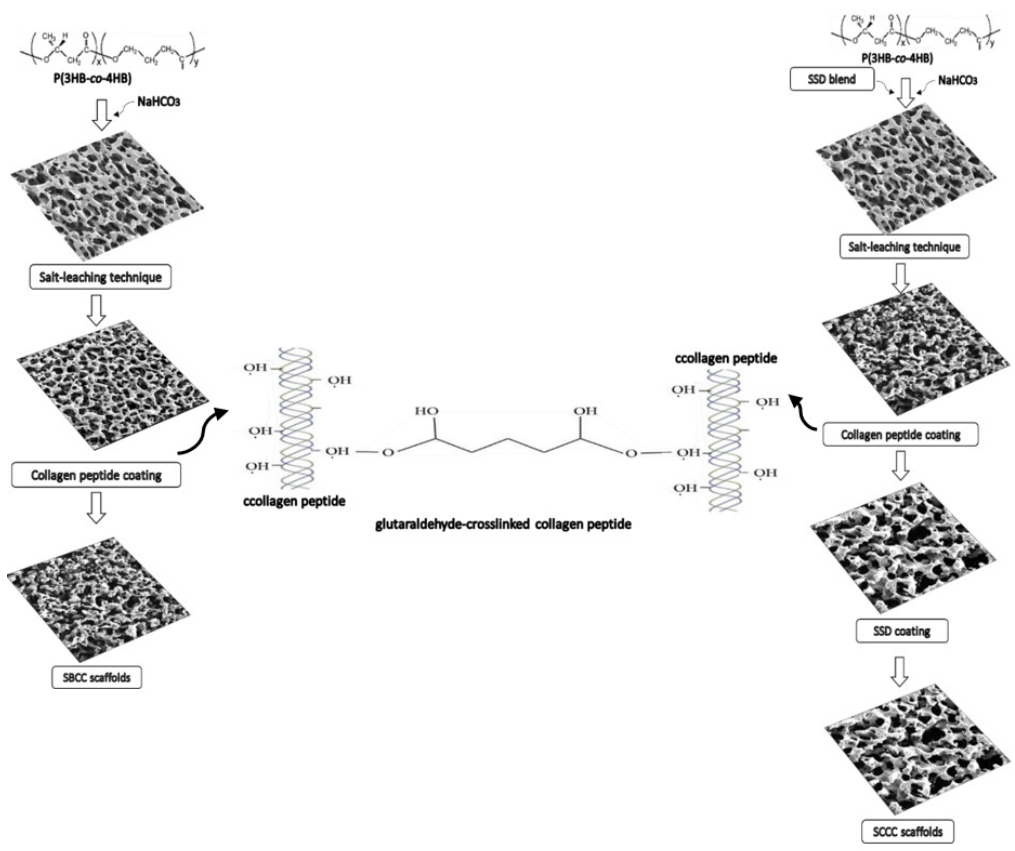
Figure 1. Schematic of fabrication of SBCC and SCCC scaffolds using a combination of salt leaching modification and freeze-drying technique with collagen peptide coating and cross-linking with glutaraldehyde.